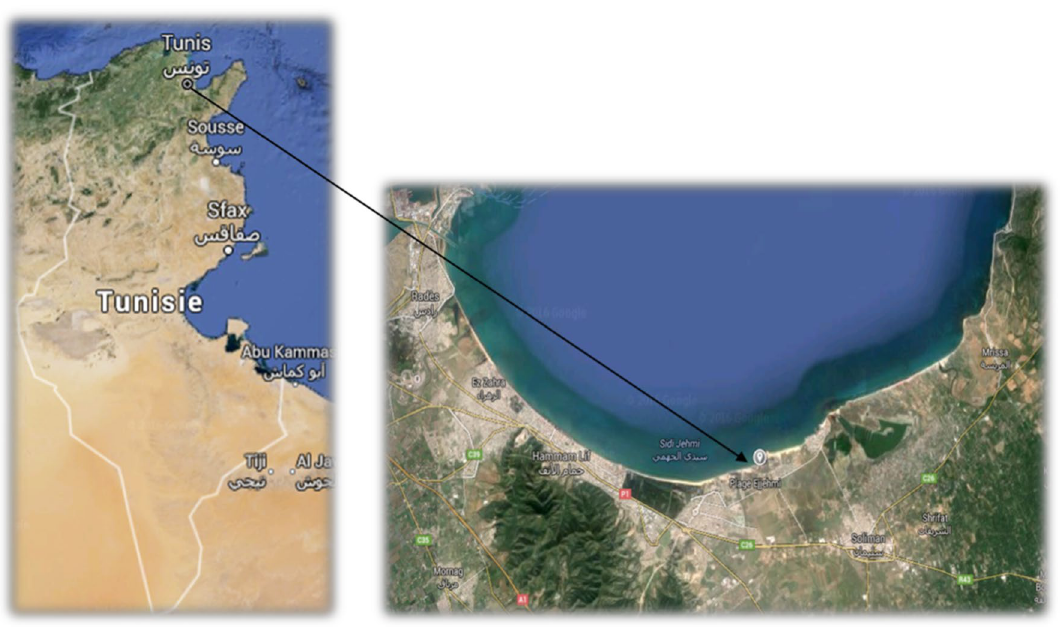
Fig. 1 sampling site. Water and sediment samples from the Sidi-Jehmi beach (north latitude: 36.72072349483175 and East Longitude: 10.438728332519531), located in Borj Cedria, Government of Nabeul, northern